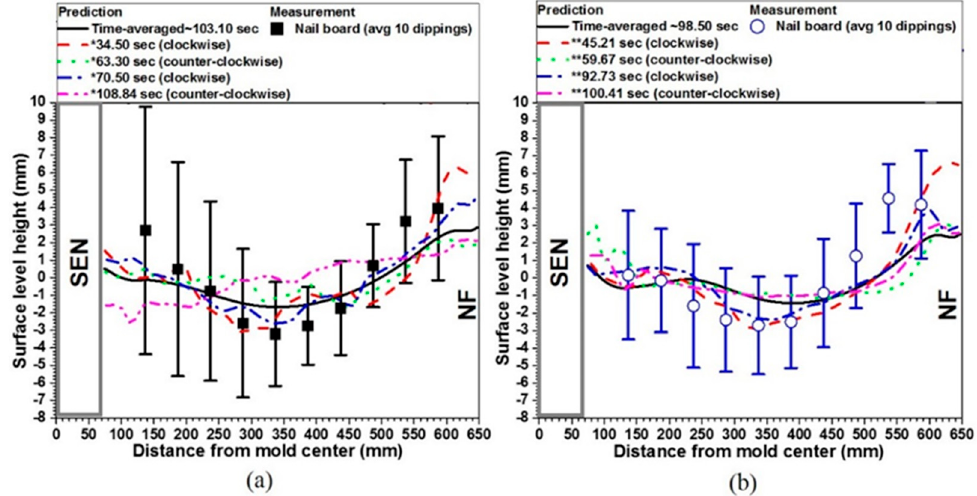
Figure 16. Surface level variations comparing LES modeling and measurements ( a ) without and ( b ) with double-ruler EMBr [113]. ( b ) with double-ruler EMBr